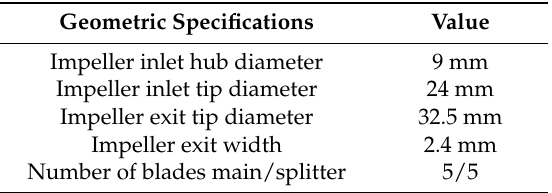
Table 1. Geometric specifications of original micro compressor.